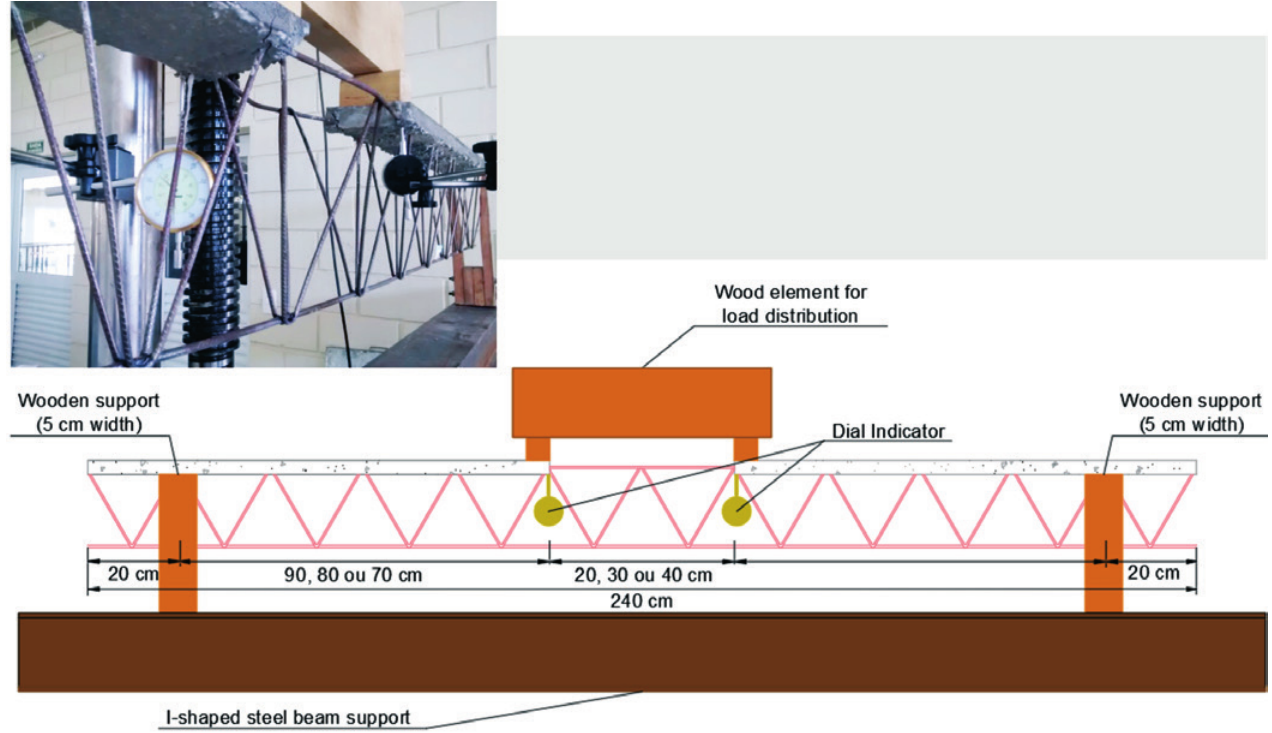
Test set-up: positioning of joists, devices for bending test and dial